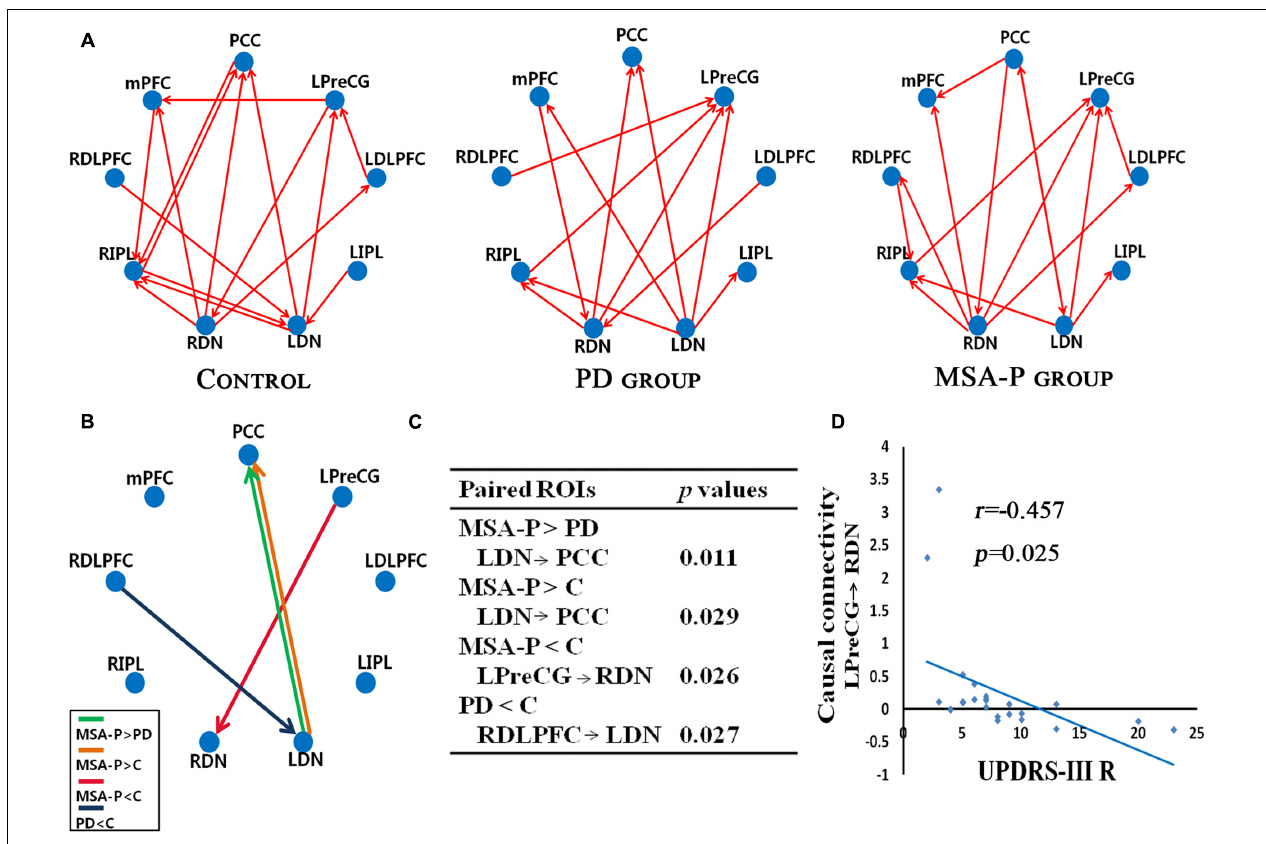
FIGURE 3 | Granger causality (GC) analysis of alterations within the cerebello-cerebral circuits among the MSA-P, PD, and control groups. (A) Significant GC patterns within the controls, PD group and MSA-P group ( p < 0.05). The red arrow indicates the direction of informational influence between paired regions; (B) significant differences in GC values between the groups: MSA-P versus controls, PD versus controls and MSA-P versus PD; (C) the p -value of each paired region is presented; (D) significant correlation between causal connectivity and UPDRS-III R scores in MSA-P group; PCC, posterior cingulate cortex; mPFC, medial prefrontal cortex; LDLPFC, left dorsolateral prefrontal cortex; RDLPFC, right dorsolateral prefrontal cortex; LPreCG, left precentral gyrus; LIPL, left inferior parietal lobe; RIPL, right inferior parietal lobe; LDN, left dentate nucleus; RDN, right dentate